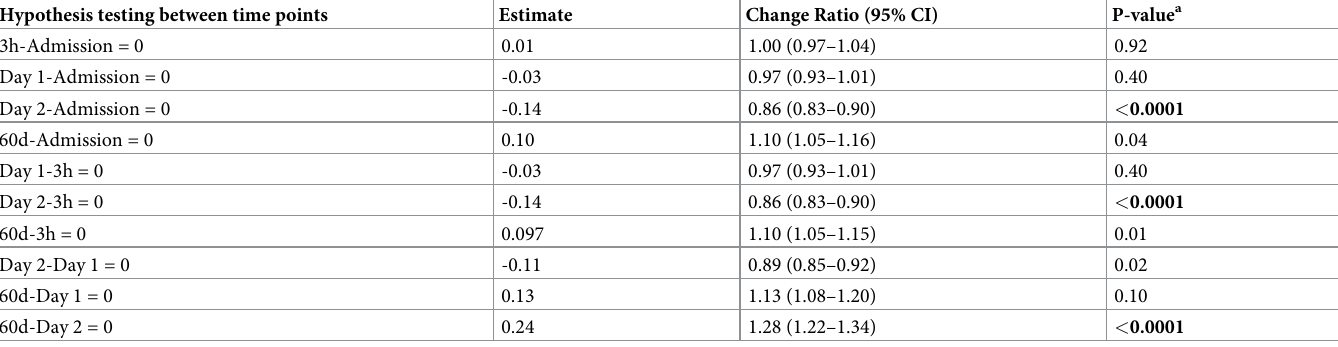
Table 4. Model estimates of relative log(SM) levels and the corresponding ratios of change between the sampling time points. Hypothesis testing between time